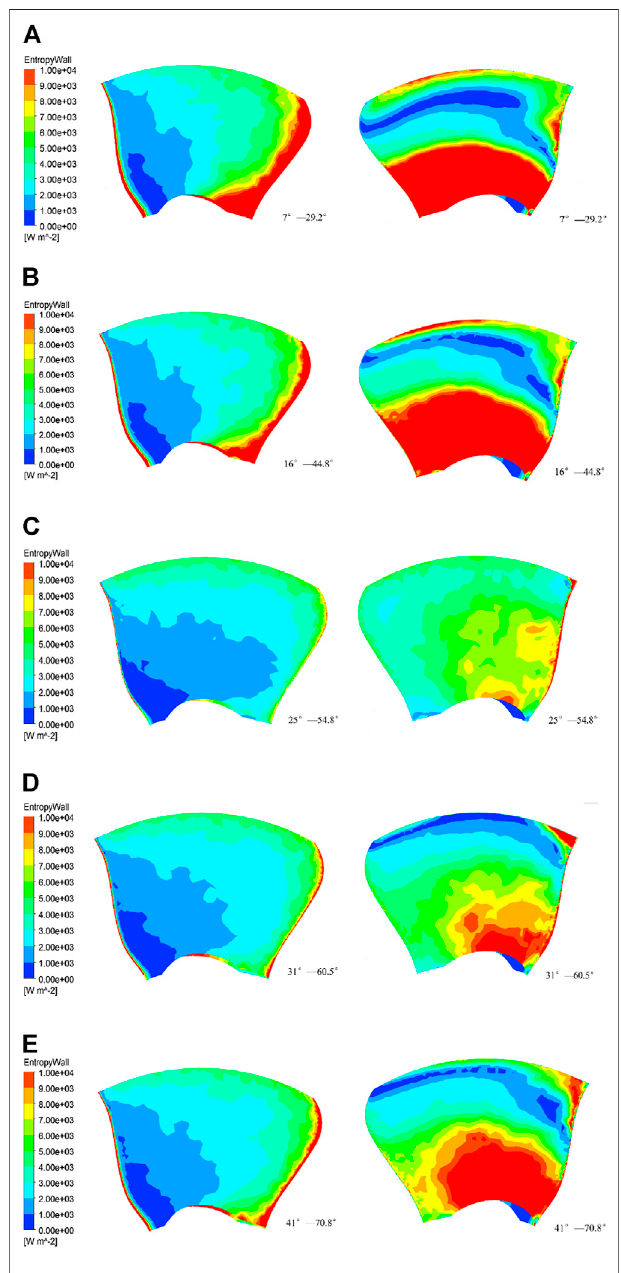
FIGURE 10 | Entropy wall distribution of the blade under the fi ve coassociated working conditions. The left side is the working surface, and the right side is the back side. (A,B,C,D,E) are the OP1, OP2, OP3, OP4, and OP5 working conditions, respectively. The entropy production values over 1 × 10 4 W m − 2 are shown in